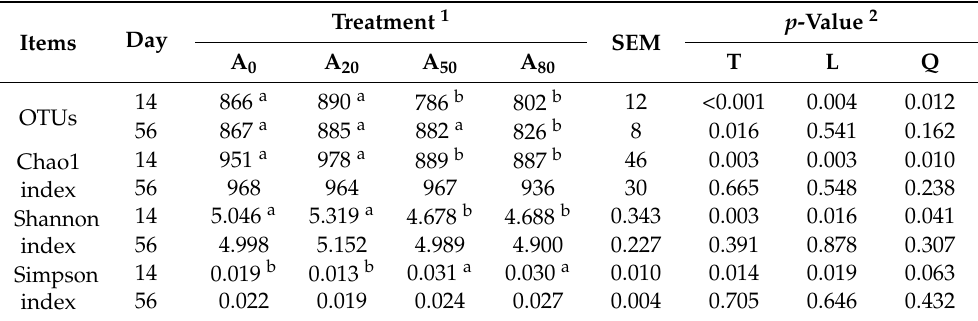
Table 2. The effect of supplementary Astralagus membranaceus (AMT) on operational taxonomic unit (OTU) richness and alpha diversity of rumen bacteria of Tibetan